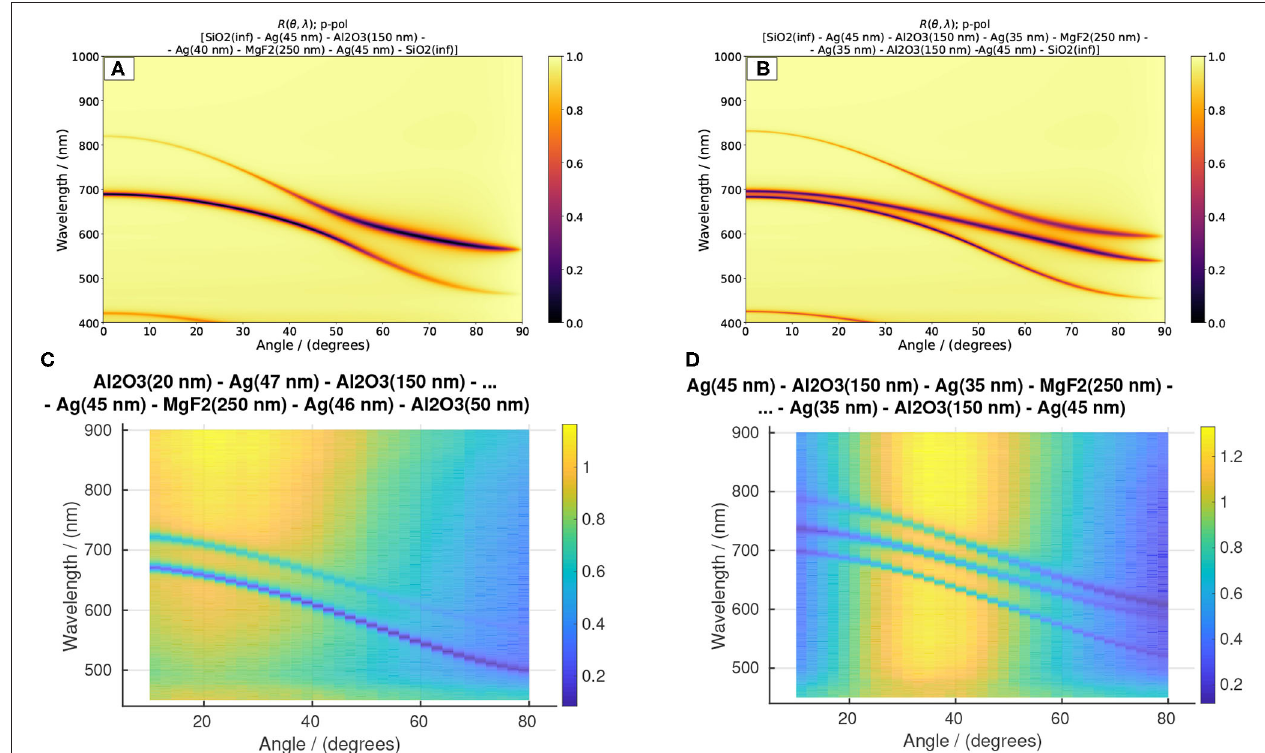
FIGURE 2 | Strong coupling in coupled planar Fabry-Pérot cavities. (A) Reflectance for two coupled cavities with different intra-cavity dielectric materials: aluminum oxide and magnesium fluoride. The strength of the coupling depends on the thickness of the inter-cavity silver layer. The tuning parameter to achieve the classical strong coupling is the angle on incidence of a plane wave. The dispersion also depends on refractive index of the first and the last medium. However, at vertical incidence the position of the resonances is almost unperturbed by changing the refractive index of the first medium. (B) Reflectance for 3 cavities. (C) Experimental reflectance for two cavities with p-polarized light illumination from air. (D) Experimental reflectance for three cavities in symmetric arrangement, where the middle cavity has the lower refractive index (MgF 2